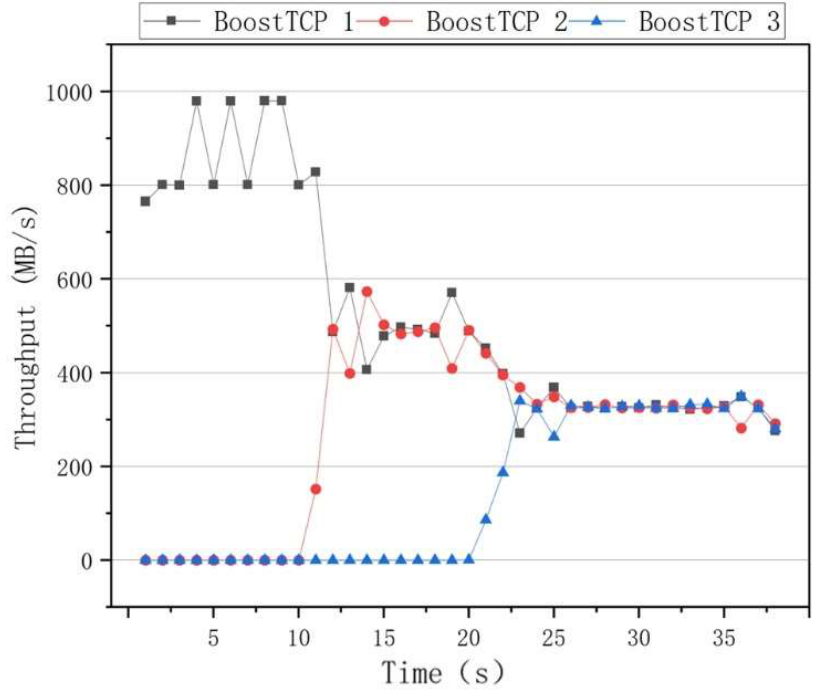
Figure 12. The fairness test curves of the BoostTCP congestion control algorithm at a network delay of 100 ms and a packet loss rate of zero.